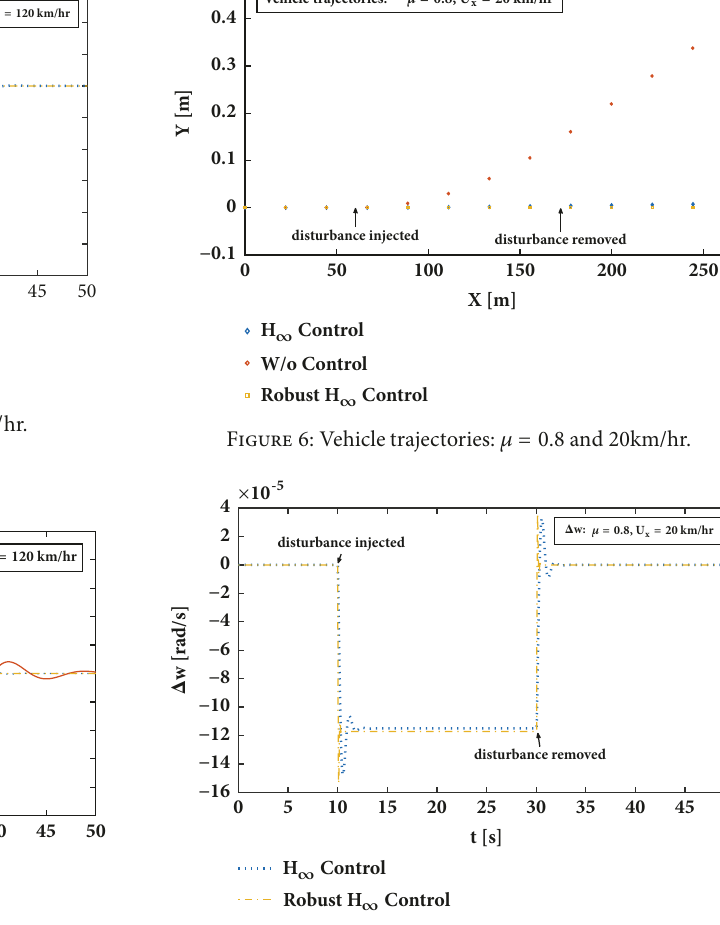
Figure 7: Control input: 𝜇 = 0 .8; vehicle speed: 20km/hr.